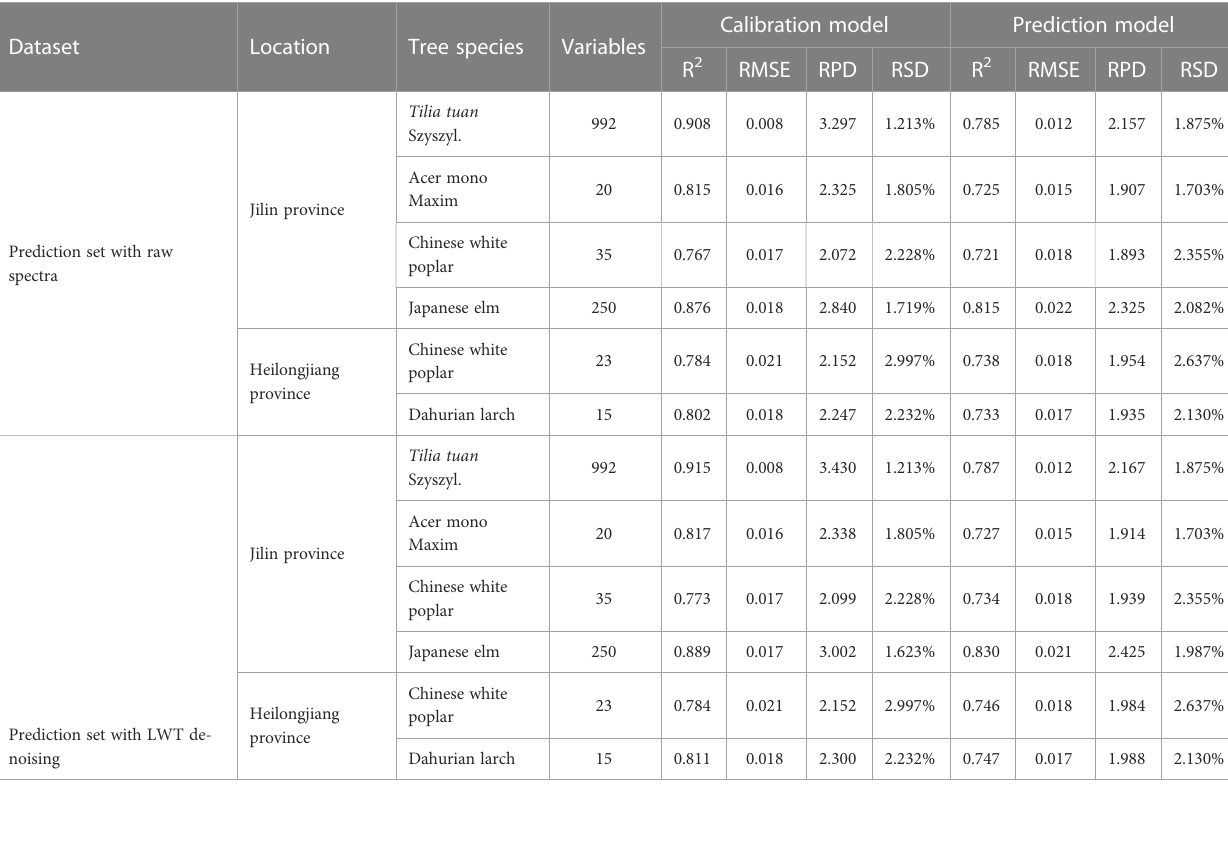
TABLE 3 The results of PSO-SVM models for prediction sets with different pretreatment.